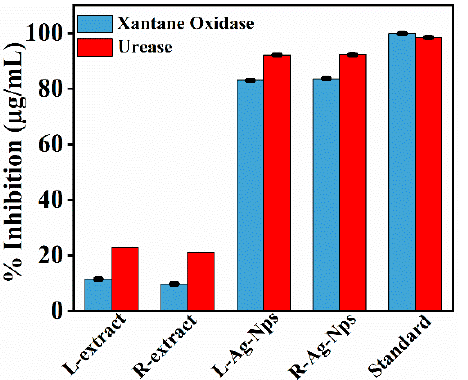
Figure 7. Enzyme inhibition of plant extract and plant extract stabilized Ag NPs. (Standard) Allo- purinol and Thiourea.